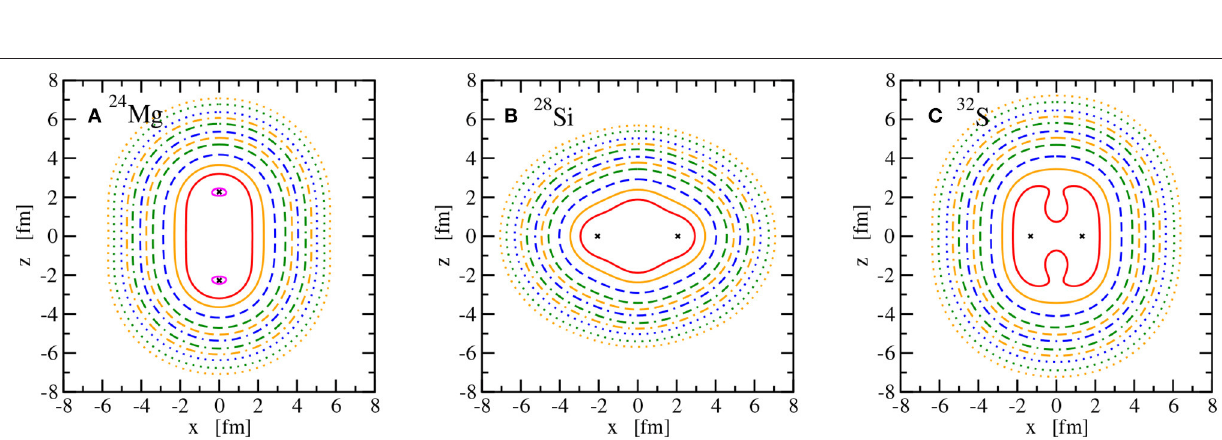
FIGURE 10 | Lines of constant intrinsic matter density ρ of the nuclei 24 Mg (A) , 28 Si (B) , and 32 S (C) . See Figure 8 for the legend. Points of maximum density are indicated with a ×